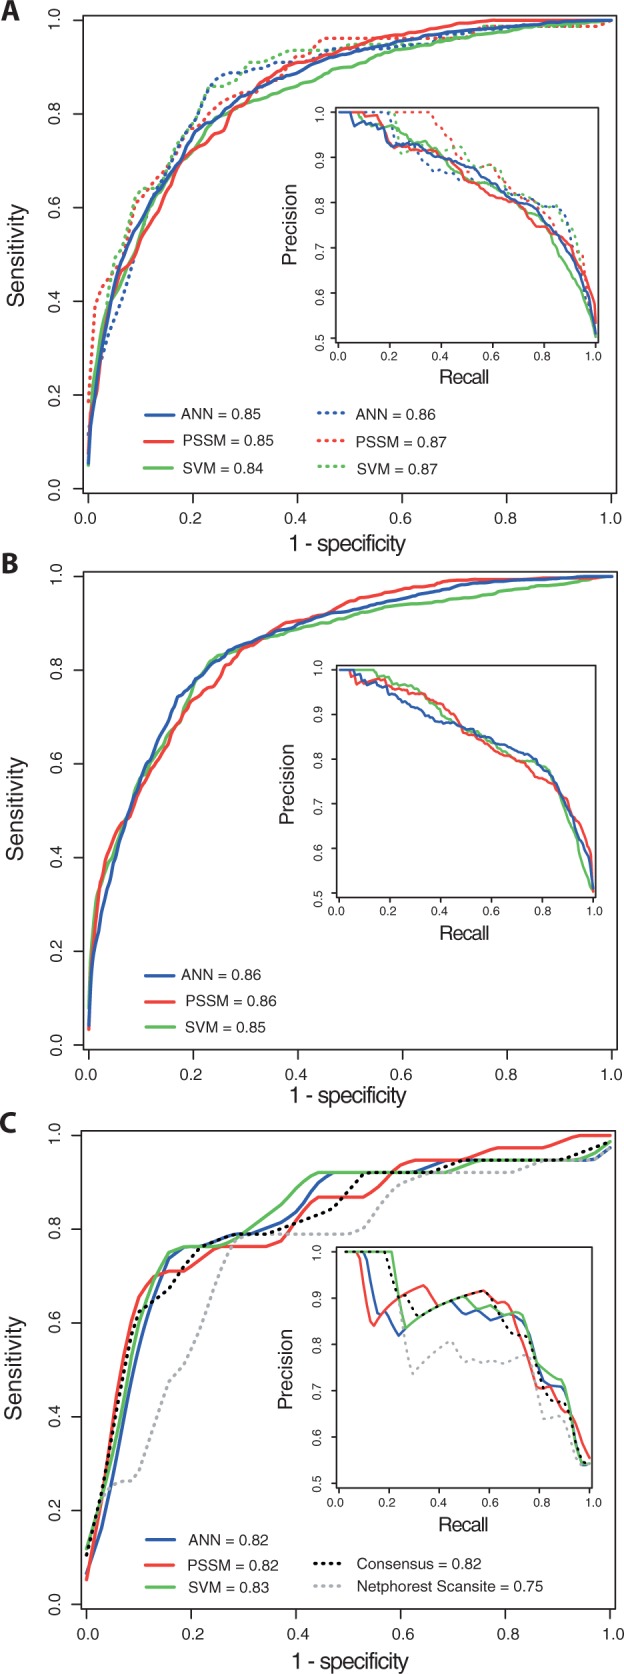
Performance of the classifiers tested by Jackknife. ROC curves and the AUC scores for (A) model training (bold line) and model testing (dotted line); (B) final models and (C) comparison to Netphorest Scansite on the BLIND dataset. ANN, PSSM and SVM models were trained at the redundancy level of at least one residue difference and for a [−6:4] motif window